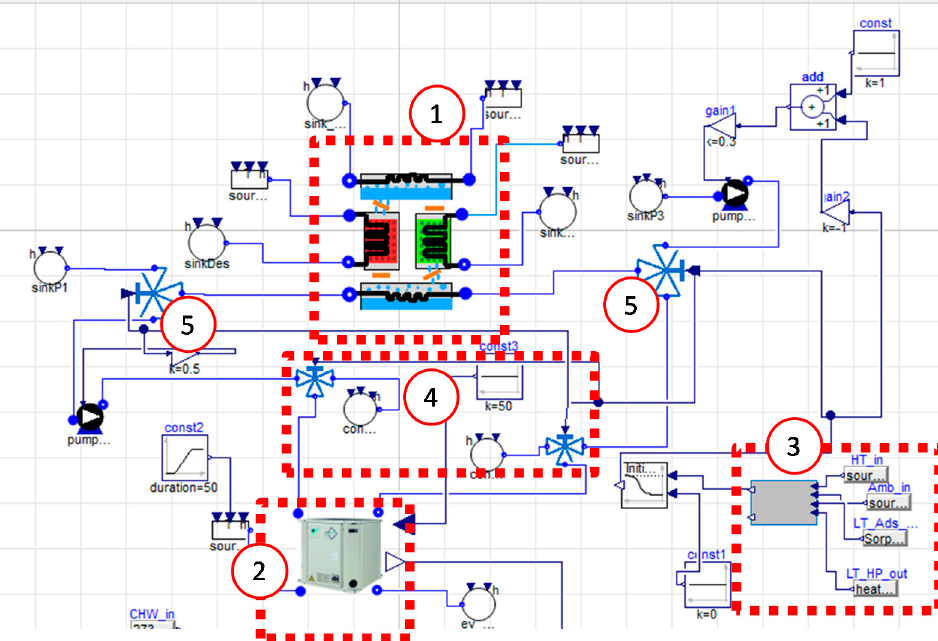
Figure 10. Dymola layout of the hybrid integrated model. 1: sorption module; 2: compression chiller; 3: control unit; 4: 3-way valve for switching between heating and cooling mode of the compression chiller; 5: 3-way valves to switch between the hydraulic connections of the units and the direct connection of the compression chiller to the heat rejection (medium temperature) circuit.